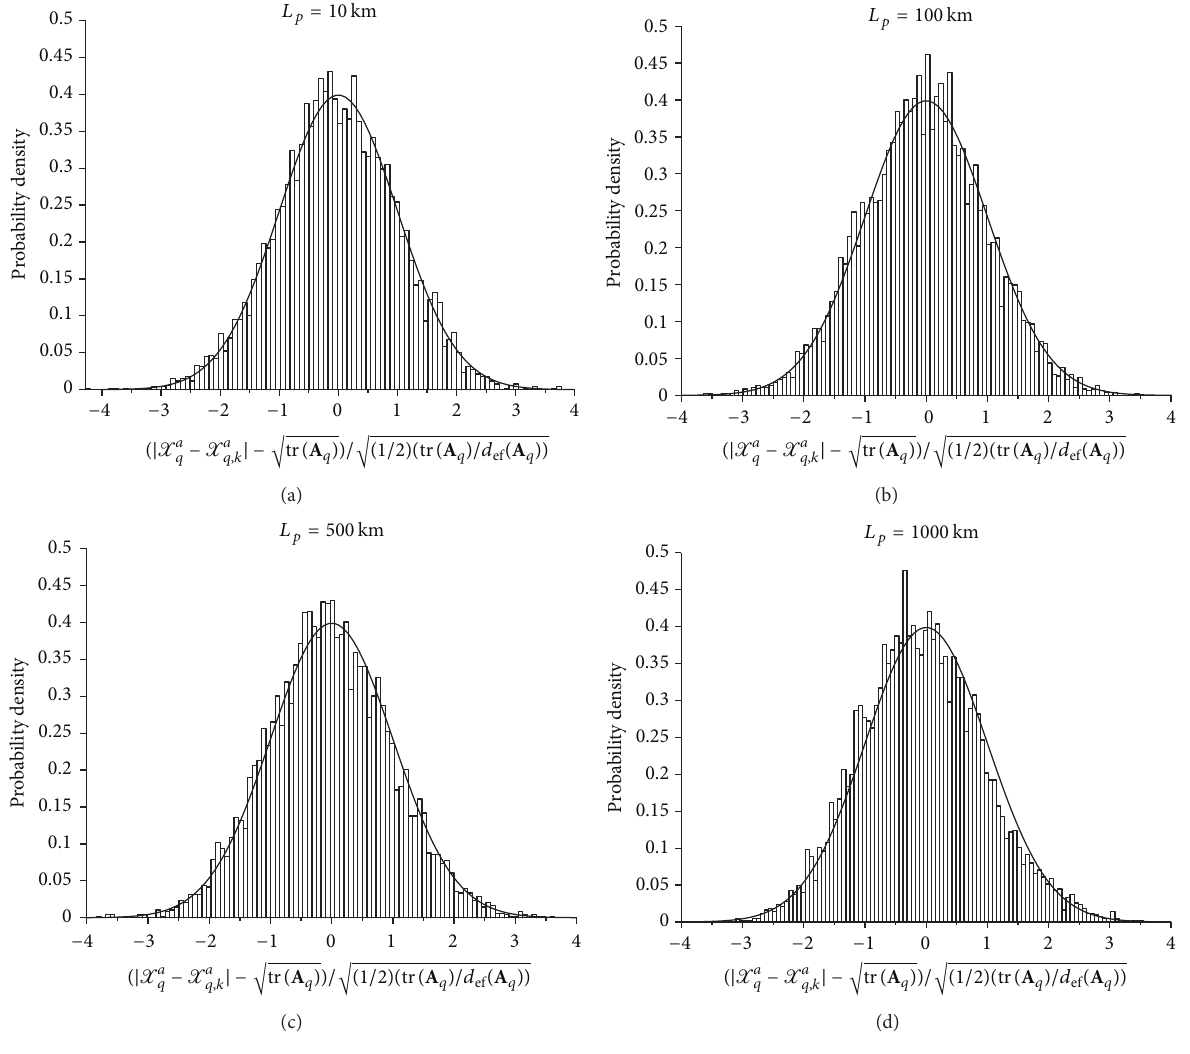
Figure 6: Histogram of distribution of the normalized distance (| X 𝑎 𝑞 − X 𝑎 𝑞,𝑘 |−√ tr ( A 𝑞 ))/√(1/2)( tr ( A 𝑞 )/𝑑 ef ( A 𝑞 )) deduced from the EnKF and comparedwiththetheoreticalasymptoticGaussianlaw N (0, 1) (solidline),estimatedfromanensembleof 𝑁 = 6400 samplesandrepresented for the different length-scale values: (a) 𝐿 𝑝 = 10 km, (b) 𝐿 𝑝 = 100 km, (c) 𝐿 𝑝 = 500 km, and (d) 𝐿 𝑝 = 1000 km, for the dimension set to 𝑛 = 1000